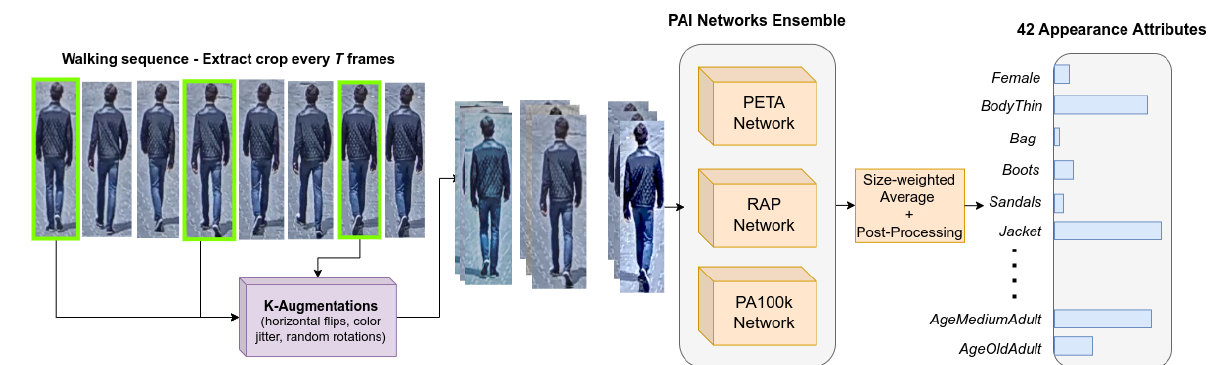
Figure 2. Overview of the automatic annotation procedure for the 42 appearance attributes. To robustly annotate attributes, an ensemble of pretrained networks is used in conjunction with multiple augmentations of the same crop. Predictions across the sequence are averaged according to their bounding-box area.